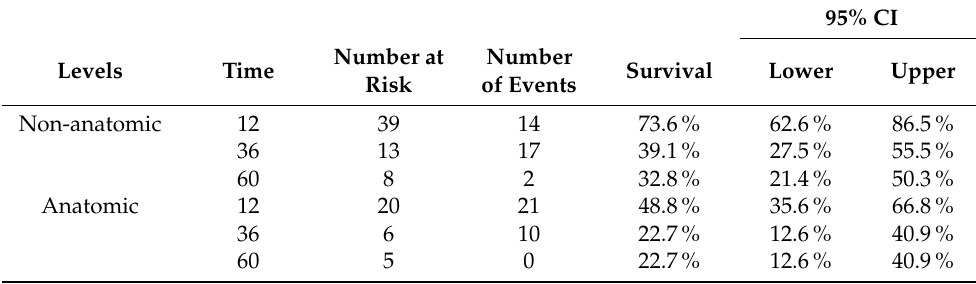
Table 3. The 1-, 3-, and 5-year disease-free survival rates of patients who underwent anatomic and non-anatomic liver resections for treatment of hepatocellular carcinoma (HCC).